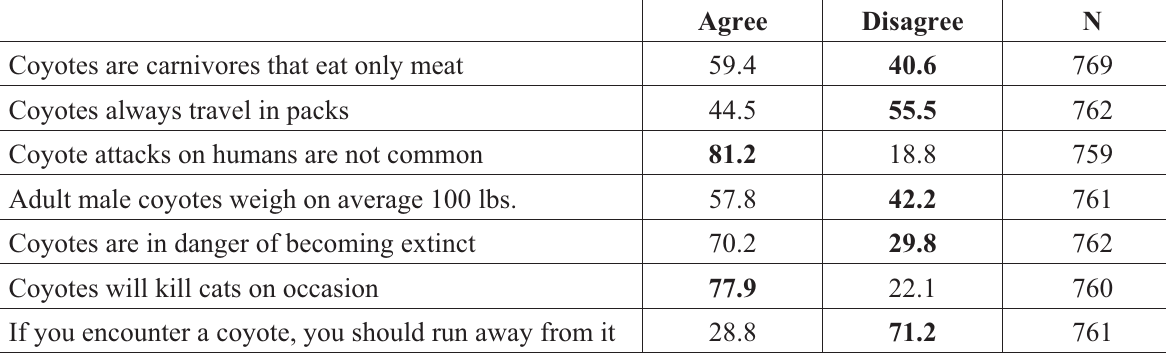
Table 5. Responses to knowledge about coyotes questions. The correct response is in bold print and italics for each question. Given in